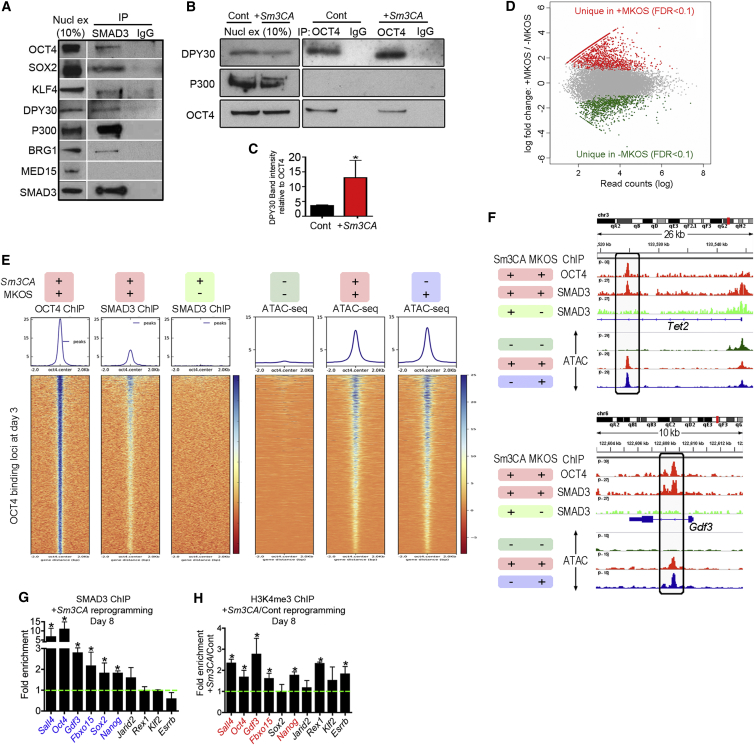
SMAD3 Interacts with Reprogramming Factors and Chromatin Remodelers and Is Localized at OCT4-Binding Sites during Reprogramming(A) Co-immunoprecipitation (co-IP) of SMAD3 and reprogramming factors or chromatin remodelers at day 4 of reprogramming with Smad3CA expression. Nucl ex, 10% of nuclear extract used for co-IP; IgG, immunoglobulin G (negative control for co-IP).(B) Co-IP of OCT4 and DPY30 at day 4 of reprogramming with control (Cont) or Smad3CA (+Sm3CA) vector expression. An interaction between OCT4 and P300 was not observed.(C) DPY30 band intensity analysis from 2 independent experiments shown in (B).(D) Comparison of SMAD3-binding peaks in MEFs with overexpression of Sm3CA or Sm3CA plus Yamanaka factors for 3 days.(E and F) OCT4, SMAD3 ChIP-seq, and ATAC-seq heatmaps at OCT4 bound loci (E) and tracks at the Tet2 and Gdf3 loci (F) with (+) and without (−) MKOS induction in the presence (+) or absence of (−) Sm3CA expression for 3 days.(G) SMAD3 ChIP-qPCR at day 8 of reprogramming with Smad3CA expression at known Oct4-binding loci in ESCs associated with pluripotency genes. Fold enrichment refers to enrichment over the averaged value of binding to known unbound regions of the Oct4 and Nanog genes.(H) H3K4me3 ChIP-qPCR at day 8 of reprogramming with control (Cont) and Smad3CA (+Sm3CA) vector expression. Data are shown as relative enrichment in +Sm3CA samples against control samples.Graphs represent averages of 2 (H3K4 ChIP) or 3 (Smad3 ChIP) independent experiments with 2 technical replicates. Error bars indicate SD. ∗p < 0.05 (one-sided t test).